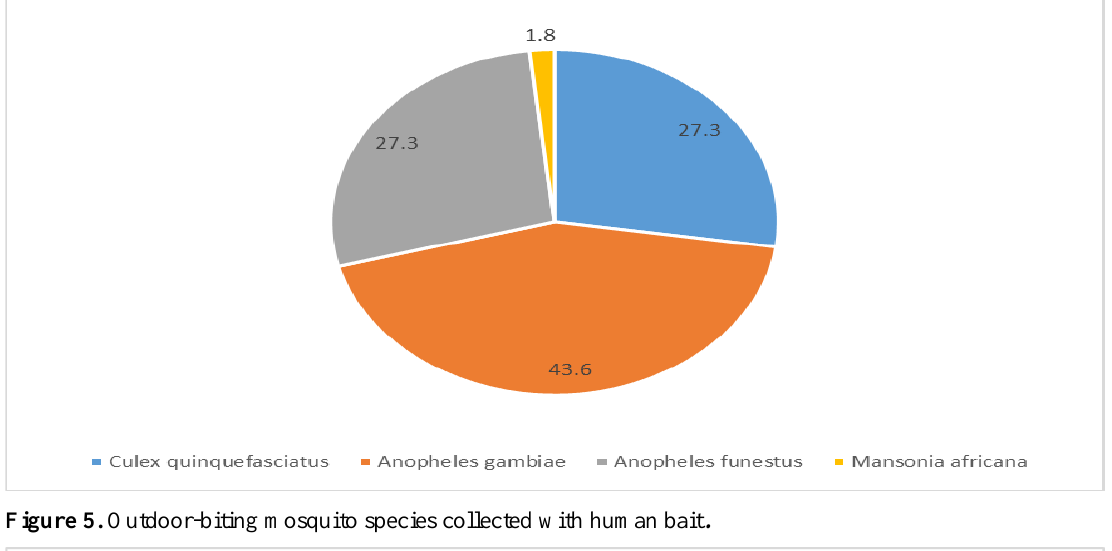
Figure 4. Relative abundance of indoor-biting mosquito species collected with Pyrethrum Knockdown collection method.